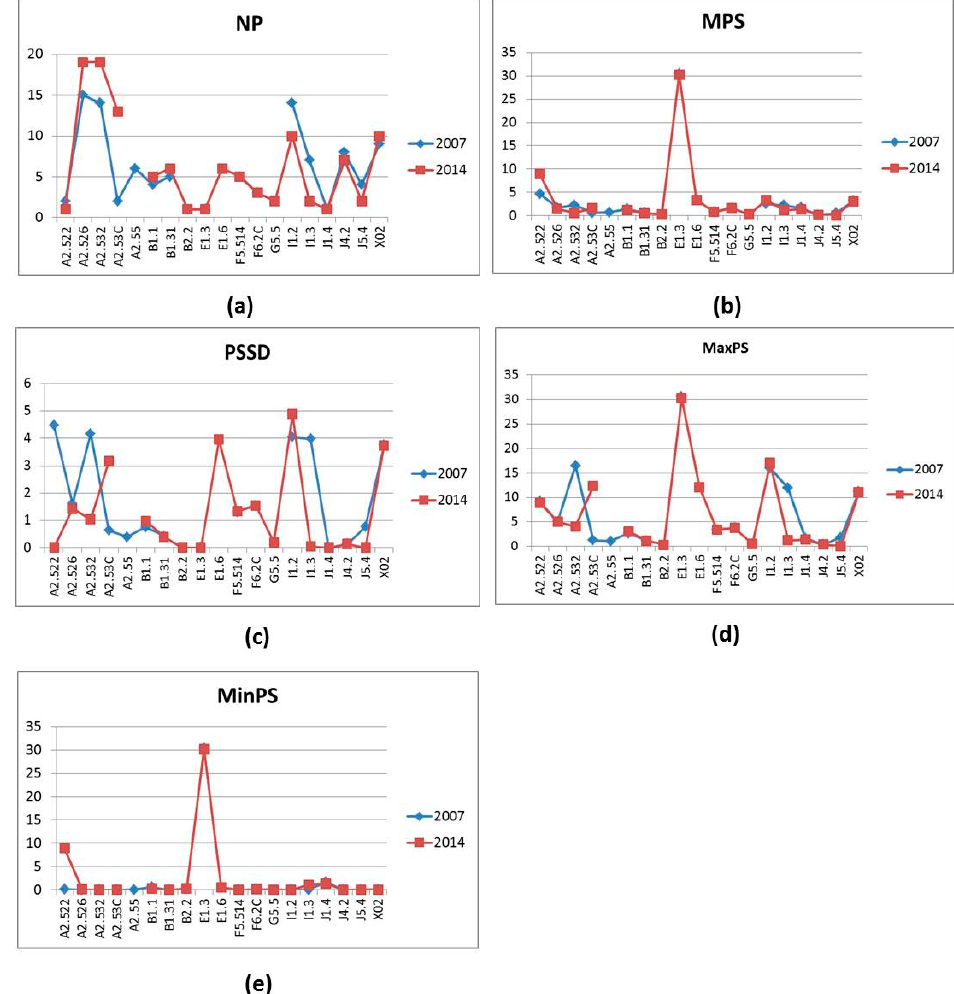
Figure 12. Diagrams comparing: ( a ) NP, number of patches; ( b ) MPS, mean patch size; ( c ) PSSD, patch size standard deviation; ( d ) MaxPS, max patch size; and ( e ) MinPS, min patch size at the SC site in 2007 and